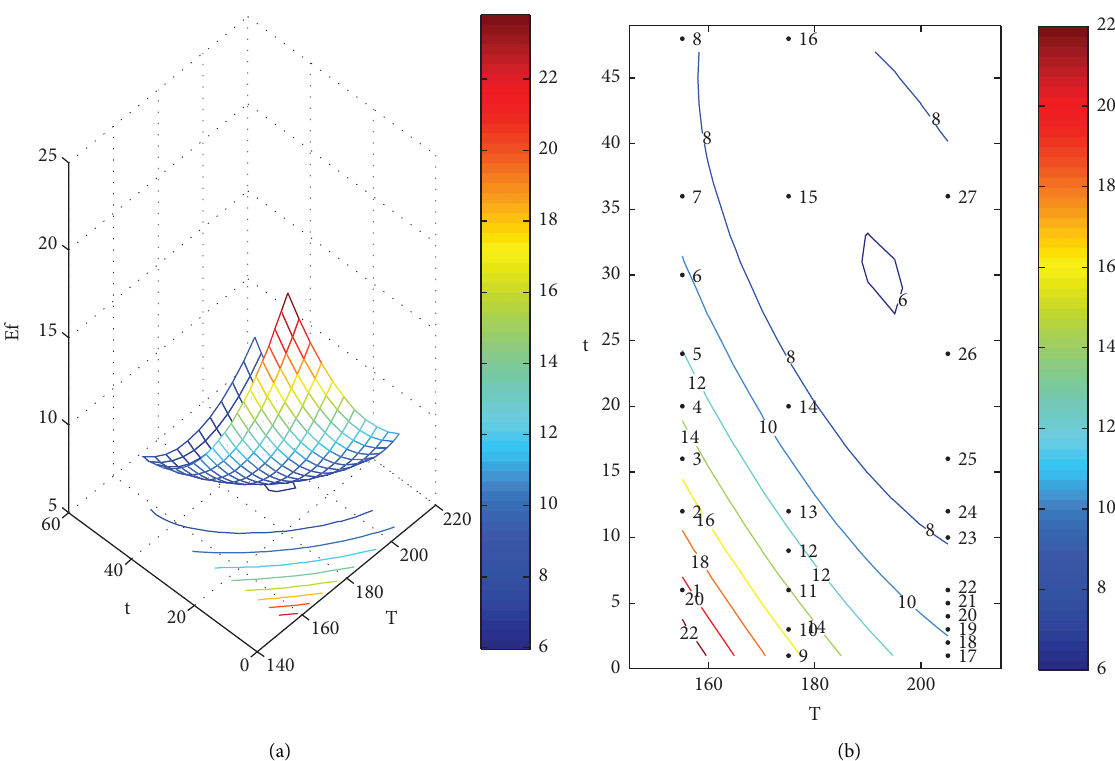
Figure 3: 3D surface graph of the regression model (a) and quality map (b) for (E) aging heat treatment condition.